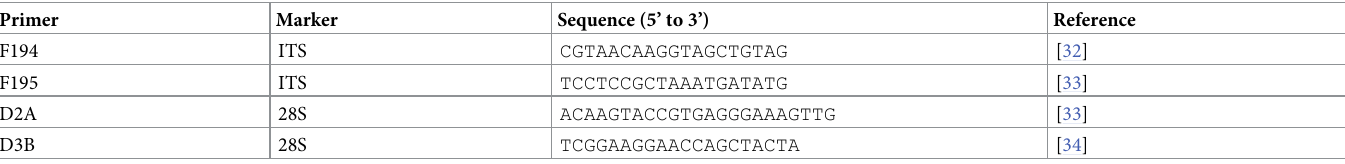
Table 2. Primers used for polymerase chain reaction and DNA sequencing of Globodera spp. individuals recovered from cultivated potatoes in